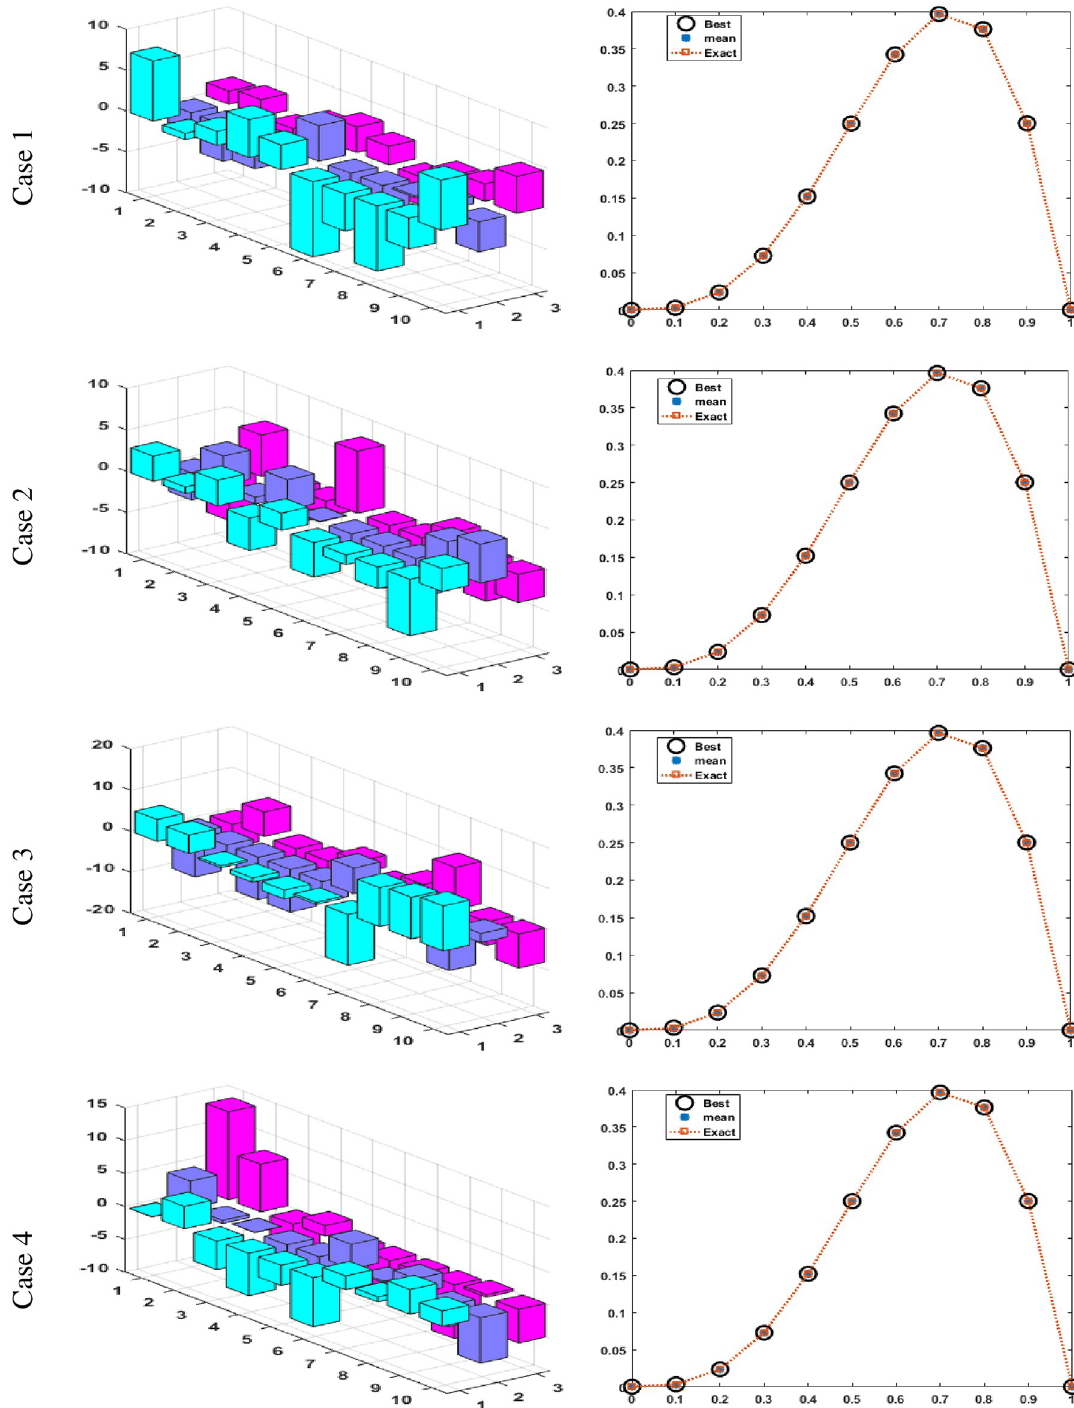
Fig 3. Set of weights and comparison of result for all cases of problem 2.